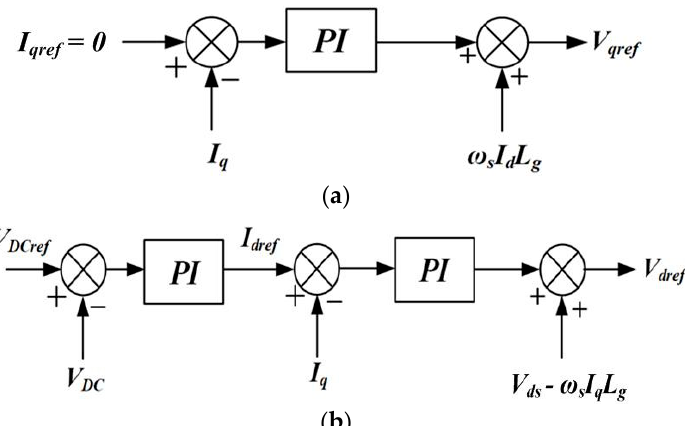
Figure 4. ( a ) q -axis control block; ( b ) d -axis control block of GSC.